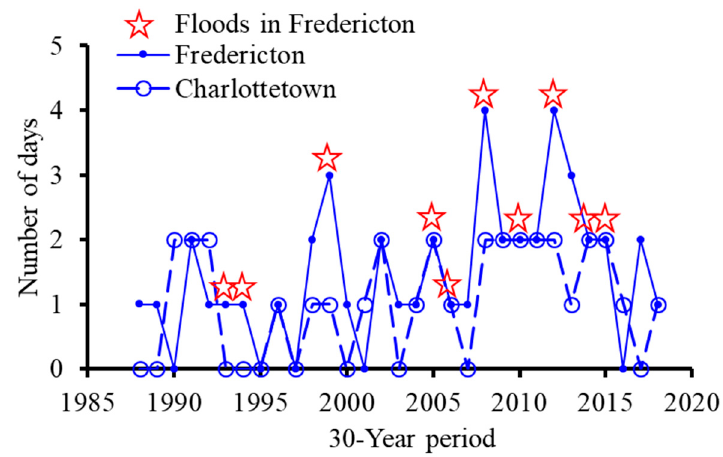
Figure 5. Number of days when daily precipitation exceeded 50 mm in Fredericton and Charlottetown during the period 1989–1918. The red stars represent flood events reported for Fredericton by New Brunswick government’s flood database during the respective years (Table 2). The open circle symbols for Charlottetown data have been enlarged to avoid hiding of Fredericton data.